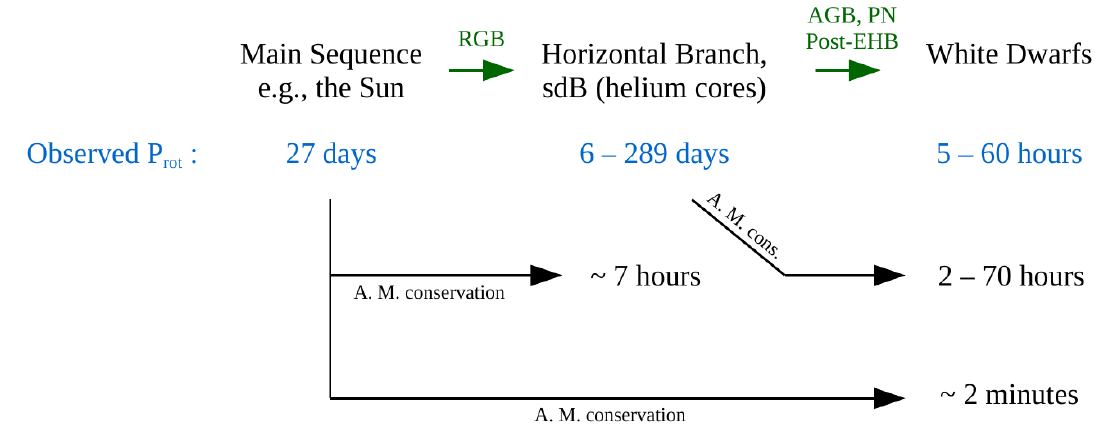
Figure 4. Schematic view of the angular momentum evolution in low-mass stars as revealed by seismic observations (source : Charpinet et al. 2016). Clearly, strong braking and loss of almost all of the initial angular momentum occurs before or during the Red Giant Branch (RGB) phase. During post-RGB evolution, the angular momentum in stellar cores is essentially preserved (see